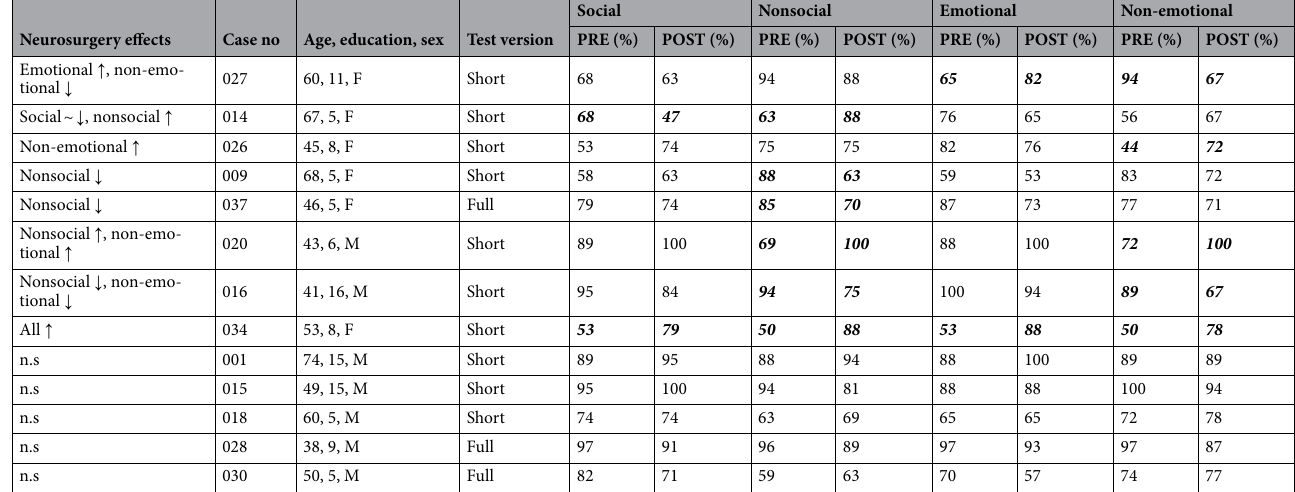
Table 3. Presurgical and postsurgical performances (proportion correct) in individual patients. ↑ / ↓ , improvement or impairment at p < .05; ~ ↓ , impairment at p < .1; n.s., p > .1, according to case-to-case comparison tests 40 . Numbers in bold and italic fonts indicate conditions with significant or marginally significant neurosurgery effects. PRE examined before surgery, POST examined shortly after surgery, Full the full-version test, Short the short-version test, F female, M